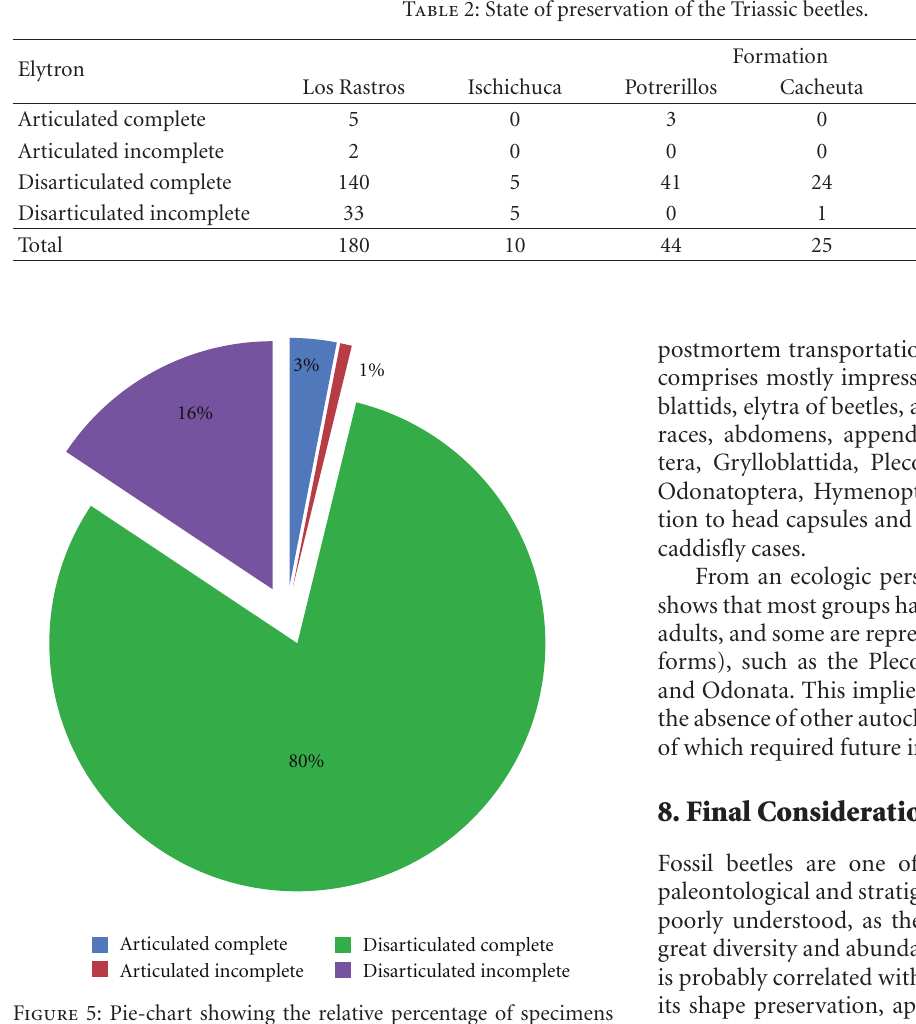
Figure 5: Pie-chart showing the relative percentage of specimens from beetle locality collection, grouped by element